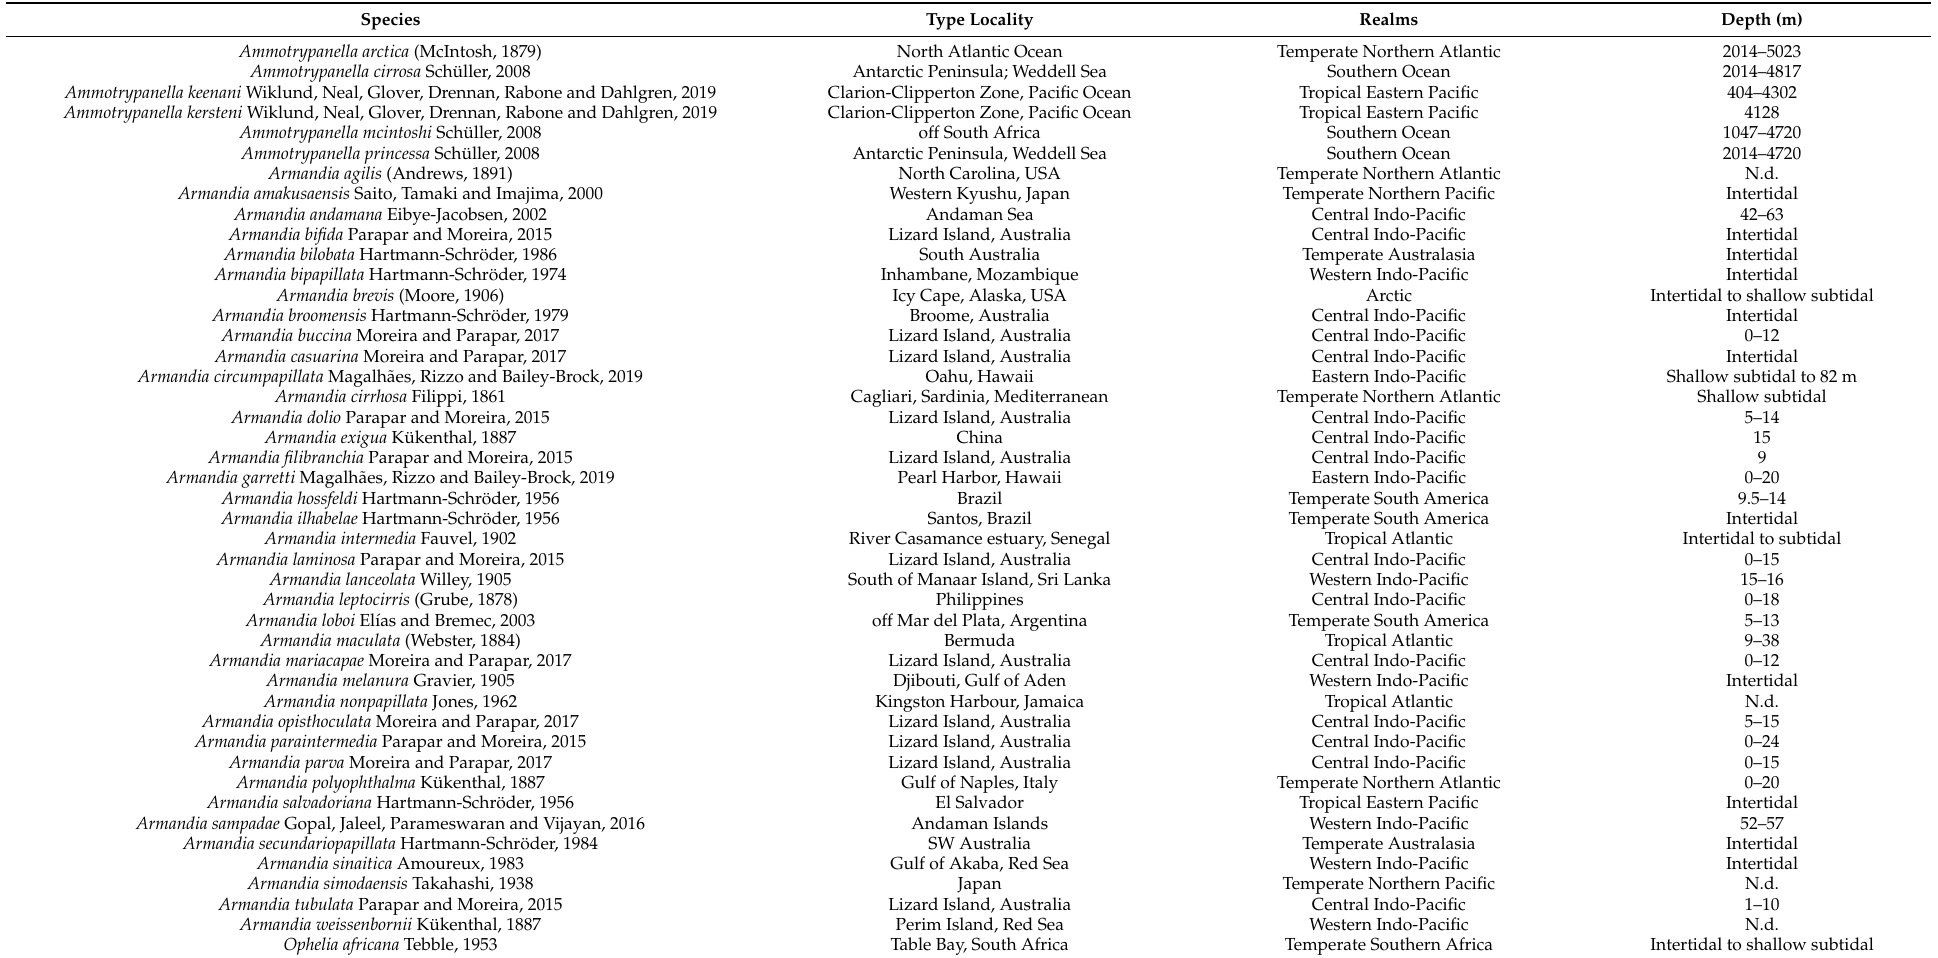
Table A1. List of valid species of Opheliidae (after Blake and Maciolek [1,3]) with their type locality, realms sensu Spalding et al. [45] and depth ranges of type locality. N.d. = no